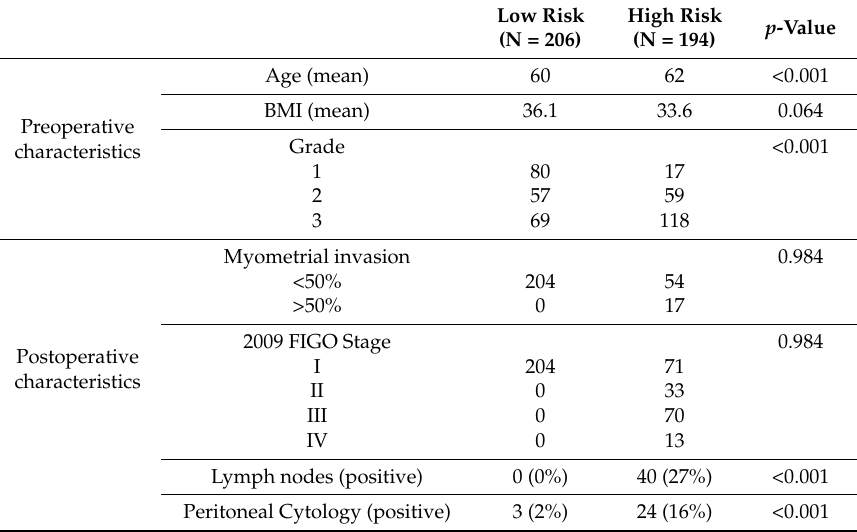
Table A4. TCGA Patient clinical and pathological characteristics (N = 400). Univariate analysis with logistic regression was used to assess differences between both groups.